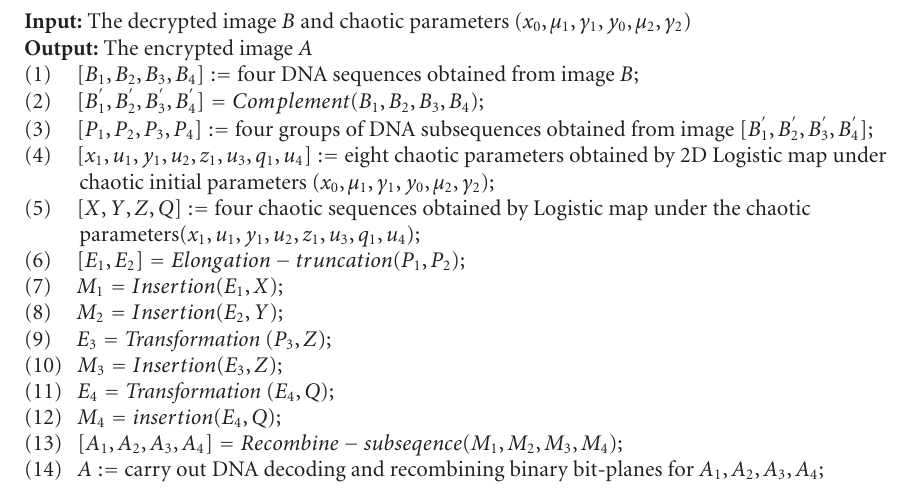
Algorithm 2: An image decryption algorithm based on DNA subsequence